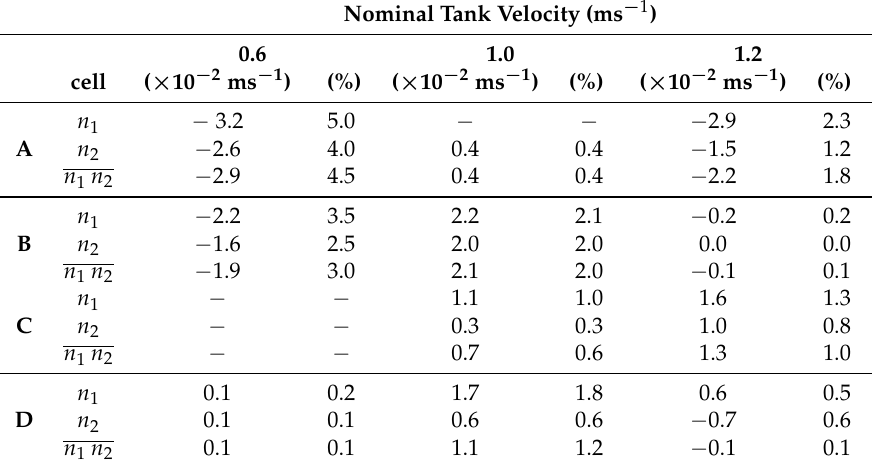
Table 8. Bias in measured mean velocities between the SB-ADP and the ADV in cms − 1 , and relative bias as a percentage of the ADV measured velocity, at the target locations A, B, C, and D. The bias was calculated using n 1 , the SB-ADP measurement cell having its centre ahead of the ADV measurement, n 2 , whose centre is after the ADV measurement, and n 1 n 2 overlapping at the ADV measurement